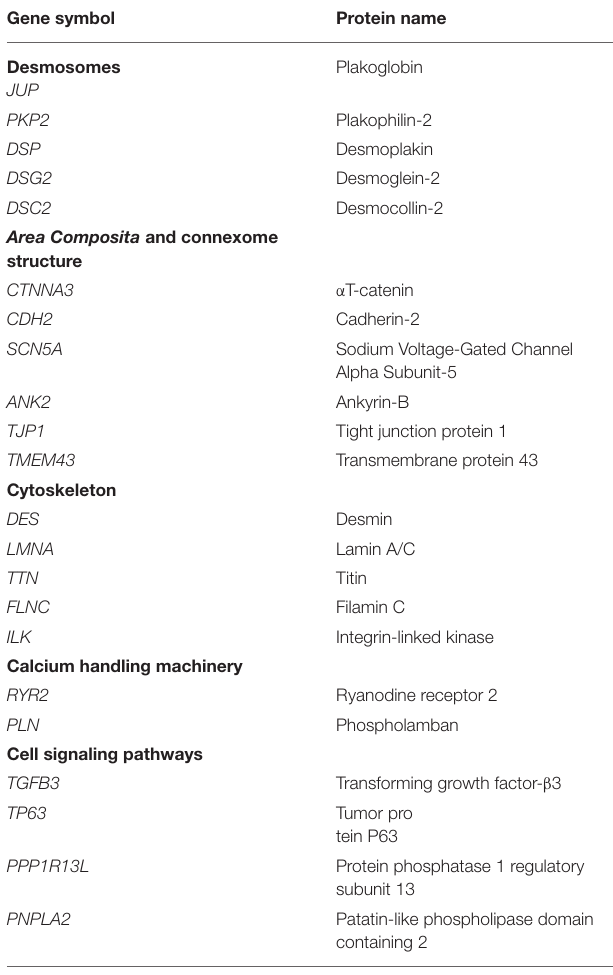
TABLE 1 | List of ACM-associated